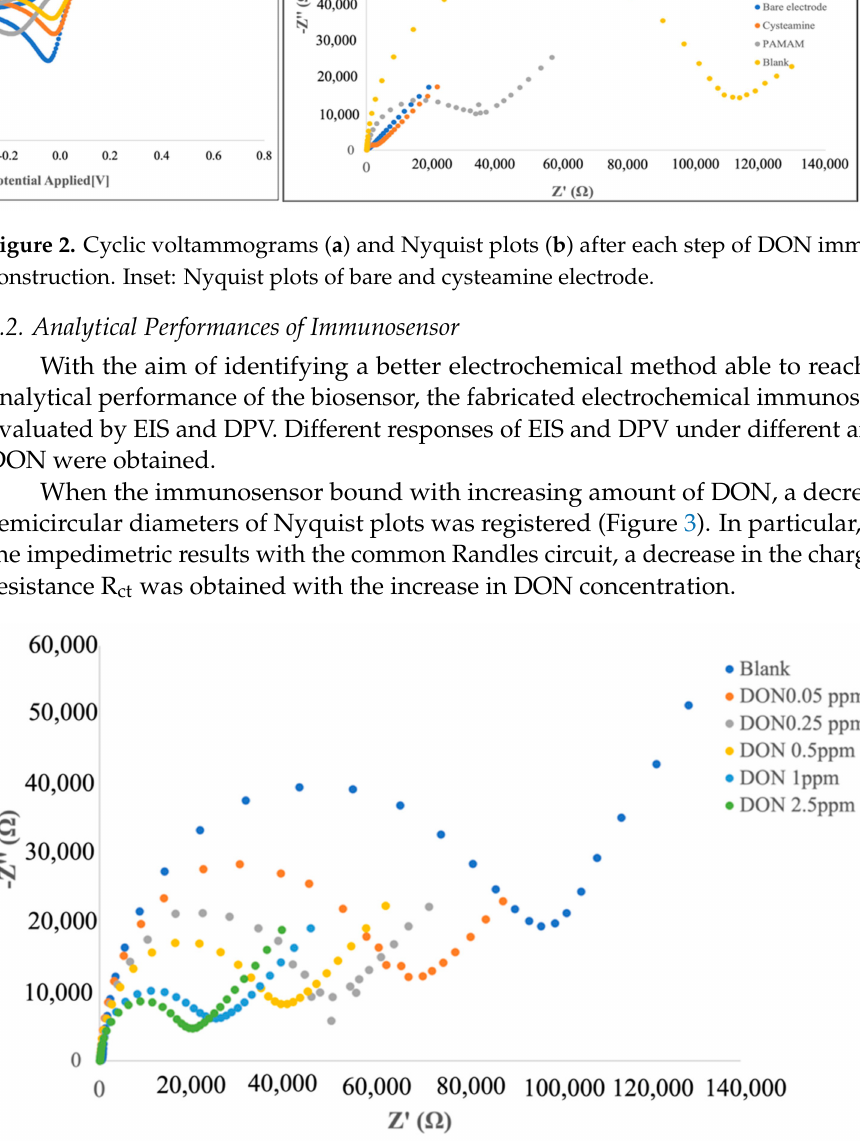
Figure 3. EIS responses of immunosensor to different amounts of